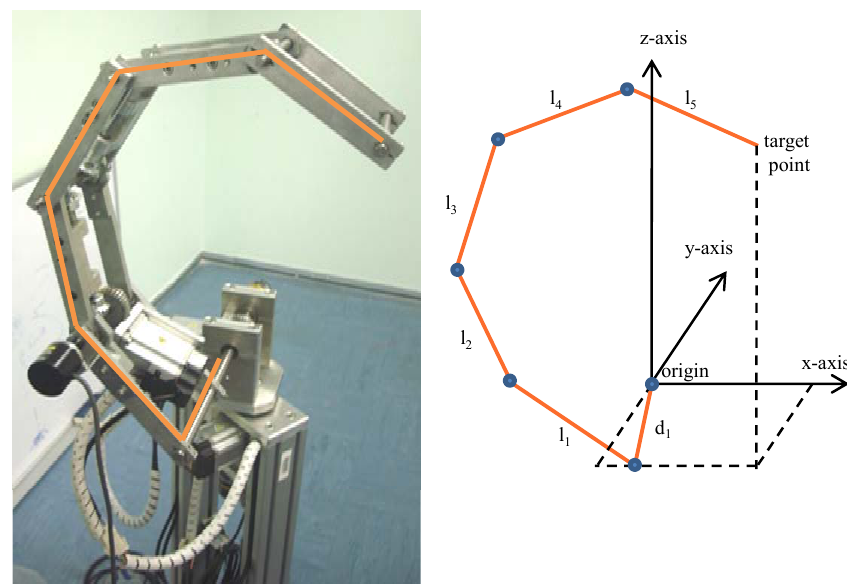
Figure 8. The manipulator used in experiments.